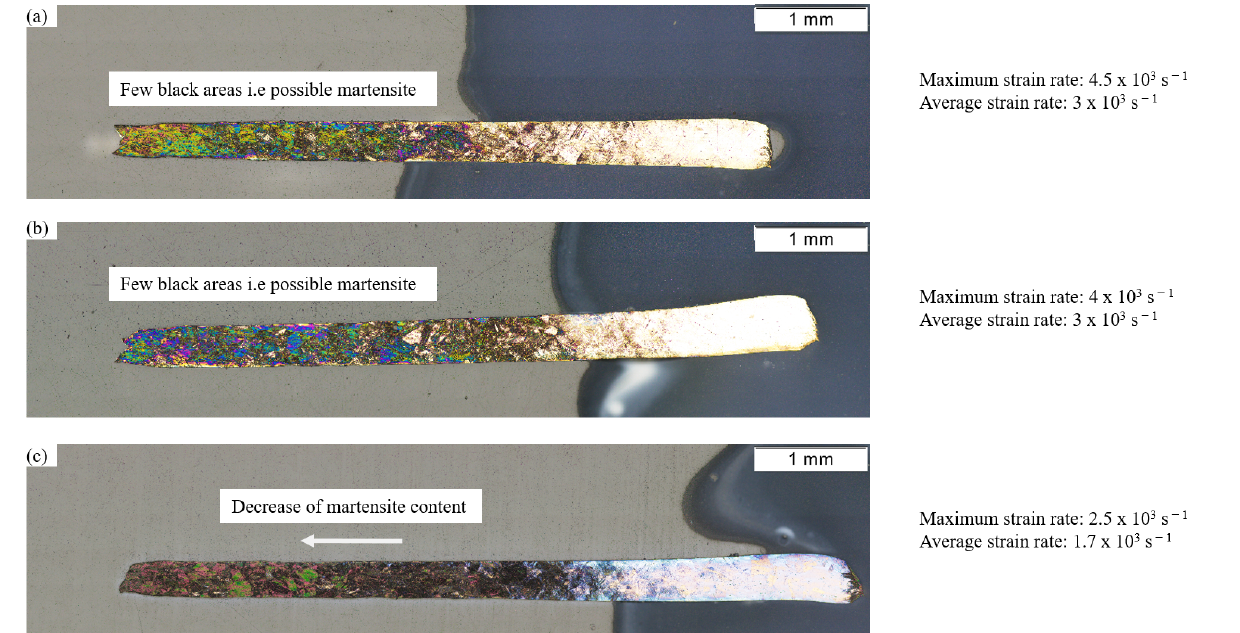
Figure 7. Microstructure after a Split Hopkinson tensile test at − 190 ◦ C for different strain rates, ( a – c ) from high to low; the samples were etched using Beraha II.